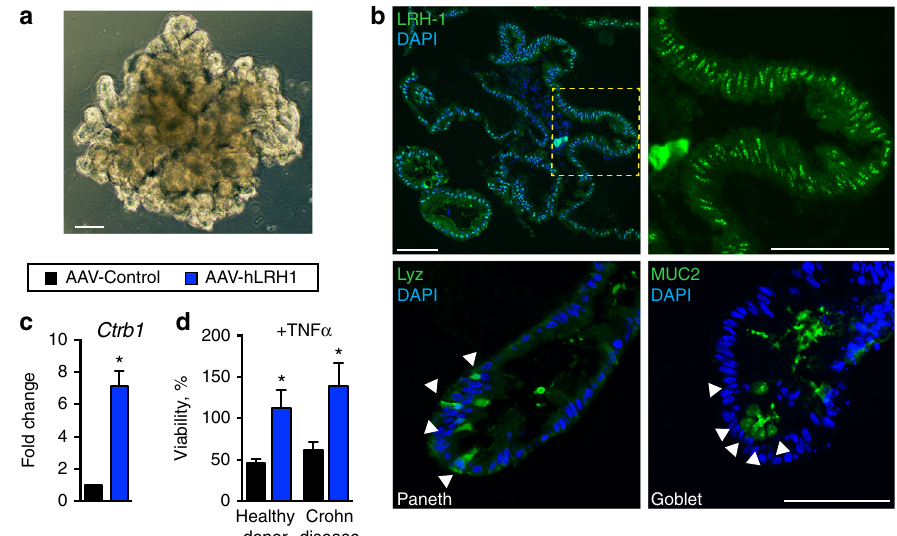
Fig. 6 Increasing hLRH-1 in human intestinal organoids protects against TNF α . a Bright fi eld view of human small intestinal organoid. Scale bar = 100 μ m. b Immuno fl uorescence for LRH-1 (green, top panels) in human intestinal organoid sections shows expression throughout the organoid with strongest expression occurring in the crypt domain (yellow dashed box and zoomed image, right). Differentiation markers for Paneth (Lyz, left) and goblet (Muc2, right) cells are shown below. Scale bar = 100 μ m. c Expression of LRH-1 target gene Ctrb1 in human intestinal organoids is upregulated 72 h after infection with AAV-hLRH1 (blue) but not with control AAV (black). d Overexpression of hLRH-1 by AAV confers resistance to TNF α -mediated cell death. Human organoids from healthy donor and a Crohn disease patient were infected with AAV-hLRH (blue) or AAV-Control (black) (3.3×10 10 genome copies) for 72 h under differentiation conditions and then exposed to TNF α (20 ng/ml, 40 h). Data represent an N of at least three replicates with ~50 organoids per well. For panels c and d error bars are SEM with statistical analyses determined by Student ’ s unpaired t test, two tailed with p values of * p = < and Use of Laboratory Animals of the National Institutes of Health. All animal studies and procedures were approved by the Baylor College of Medicine (AN- Board (IRB 15-17763) and utilized tissue from deidenti fi ed donors who had given written informed consent to the study. Animal experiments . Animals were housed and bred in SPF facility. Inducible IEC knockout line was created by crossing animals harboring CreERT2 under control of the villin promoter with Lrh1 fl / fl animals and bred to homozygosity. Lrh1 IEC-Flex line was generated with Lox-STOP-Lox-hLRH1 animals, gift of DeMayo (Baylor College of Medicine) crossed into our Lrh1 IEC-KO line. For animal knockout and activation studies, tamoxifen was dissolved in sun fl ower oil and delivered by two